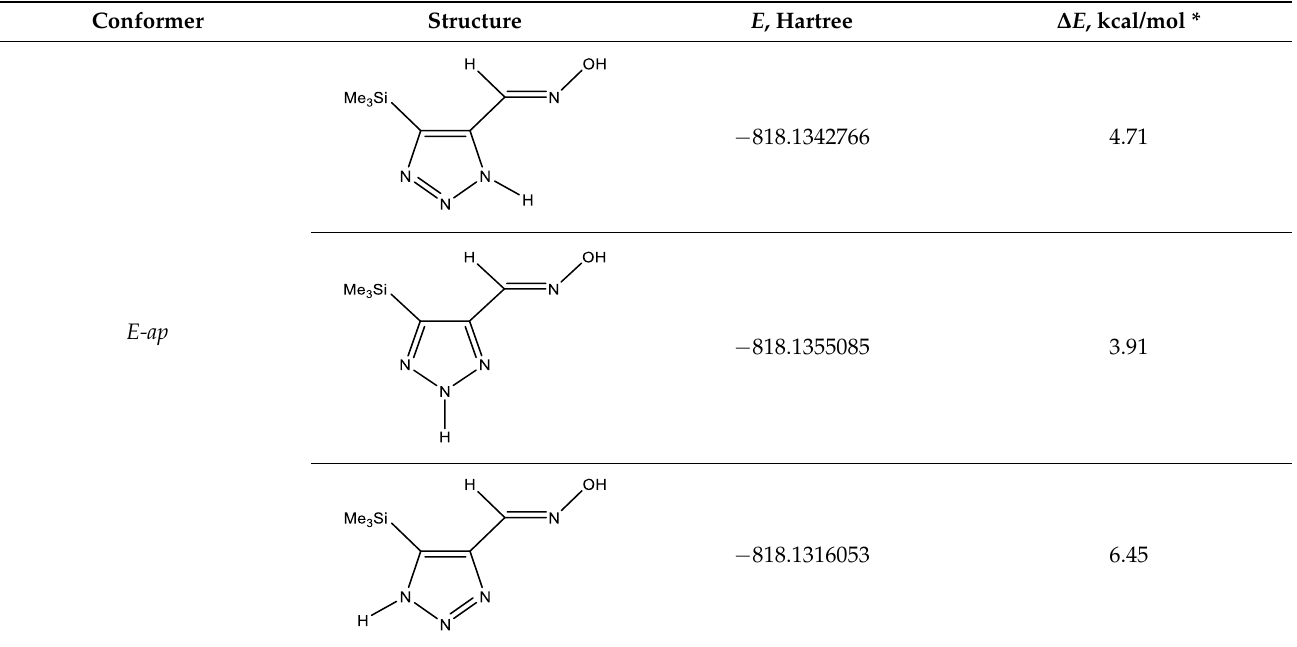
Table 5. Possible conformers of 4-trimethylsilyl-1,2,3-triazole-5-carbaldehyde oxime, optimized at the MP2/aug-cc-pVTZ level [113].